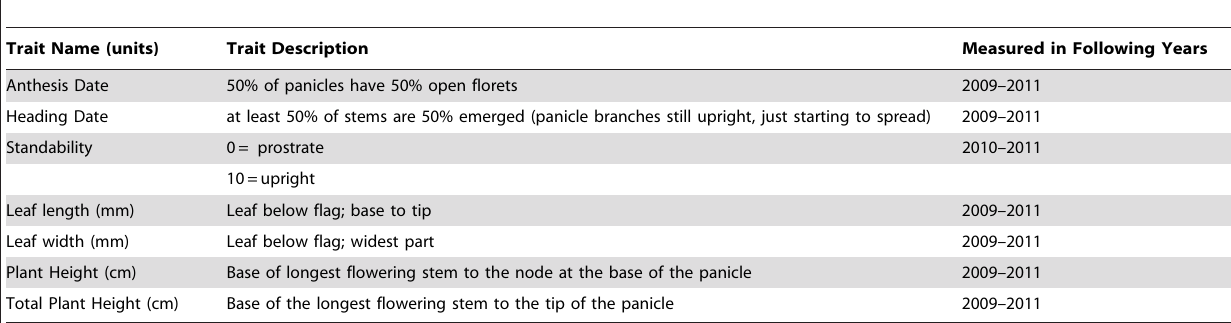
Table 1. Phenotyping protocol for seven morphology traits measured in three summer environments, in Ithaca, NY across three years.